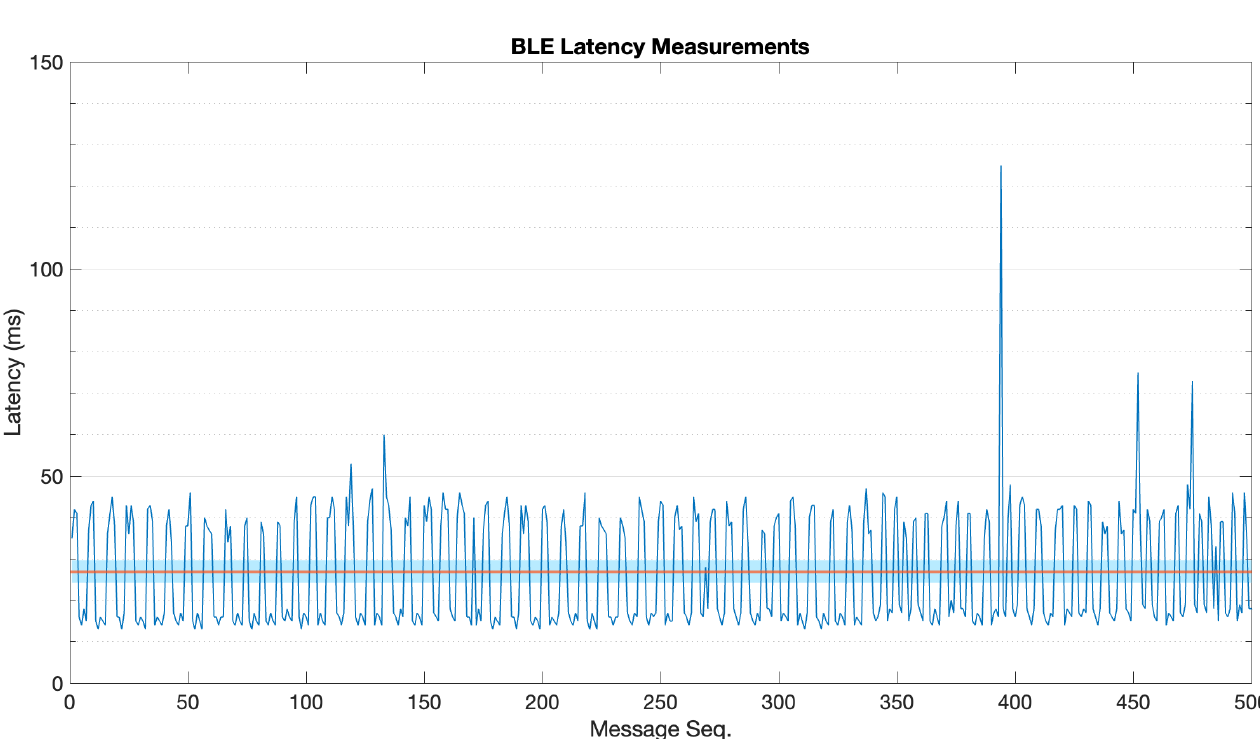
Figure A7. Latency plot for BLE.